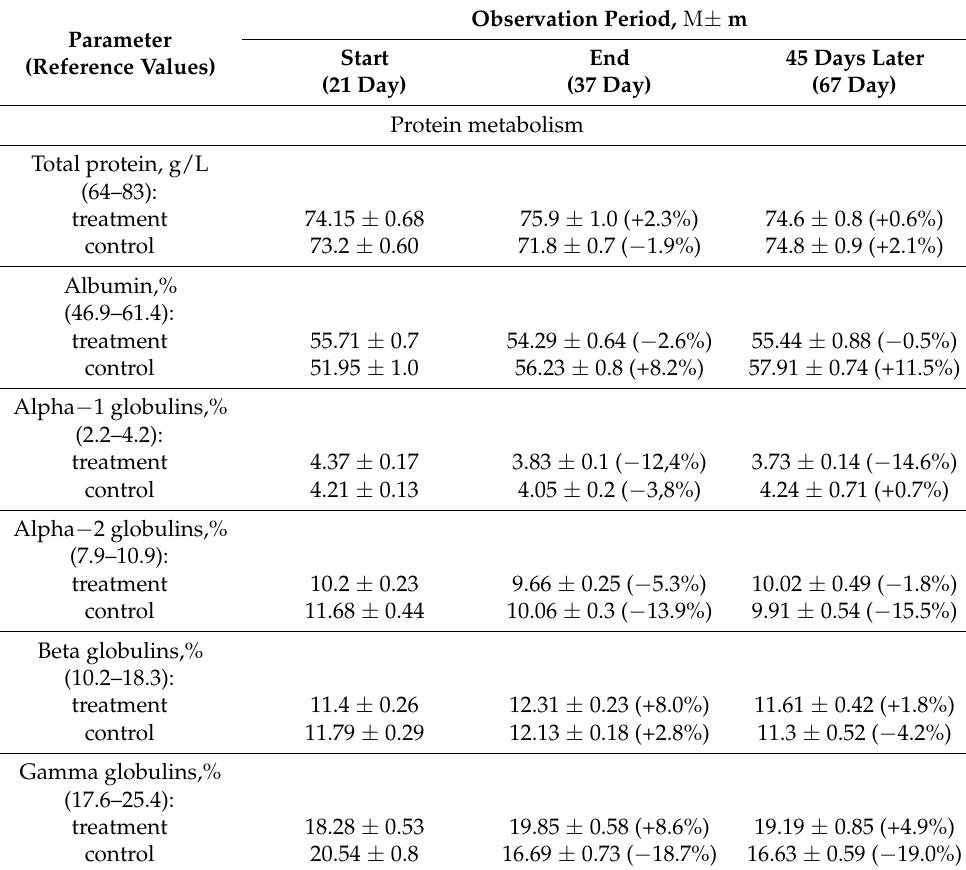
Table 4. Protein metabolism indicators during the observation period (absolute values).